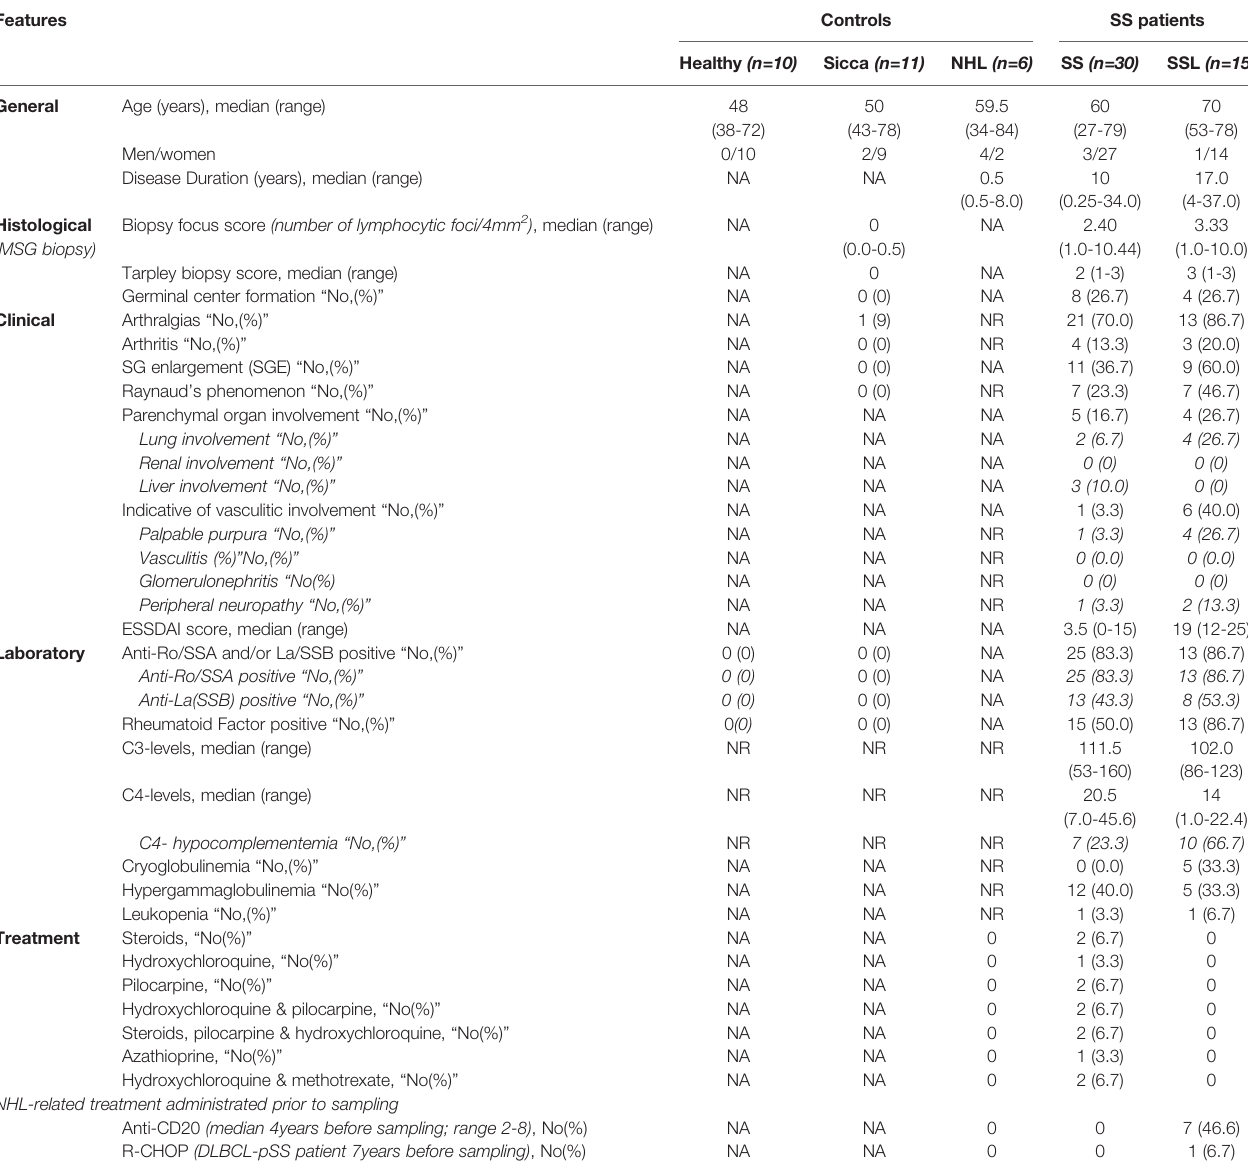
TABLE 1 | Characteristics of the patients studied. Features